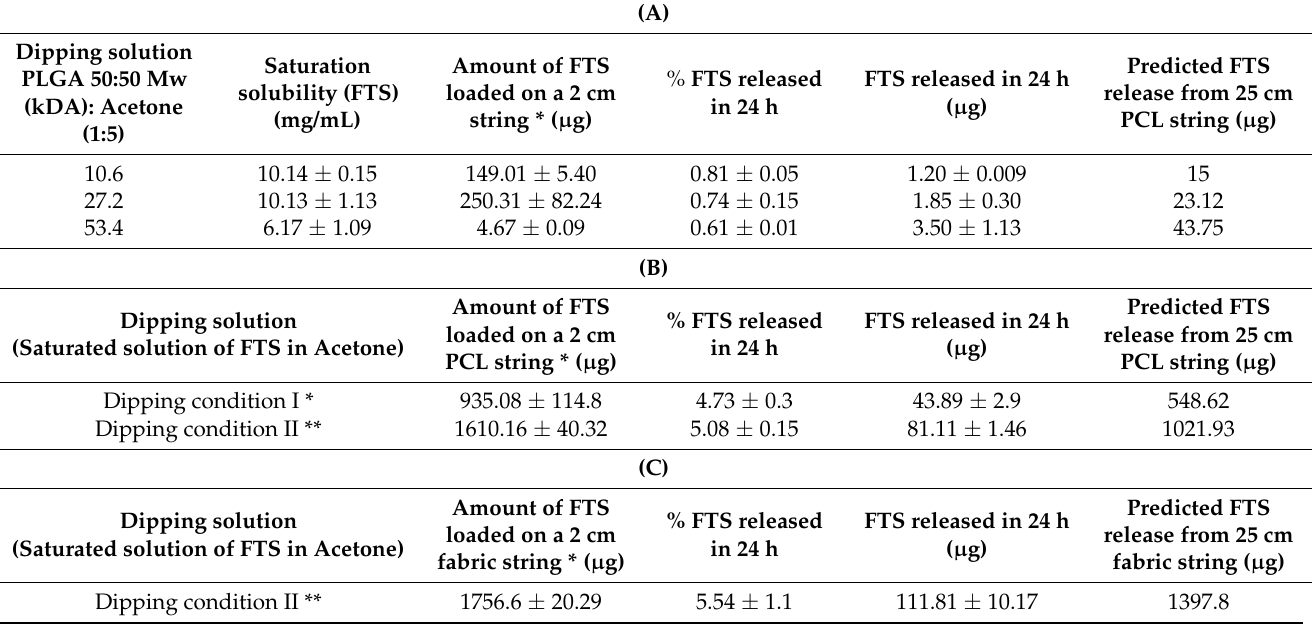
Table 1. In vitro release kinetics of FTS from PCL strings and fabric strings (A) In vitro drug release profile of FTS loaded PCL string (2 cm L) and predicted profile for a 25 cm L string. (B) In vitro release profile of FTS loaded PCL string at